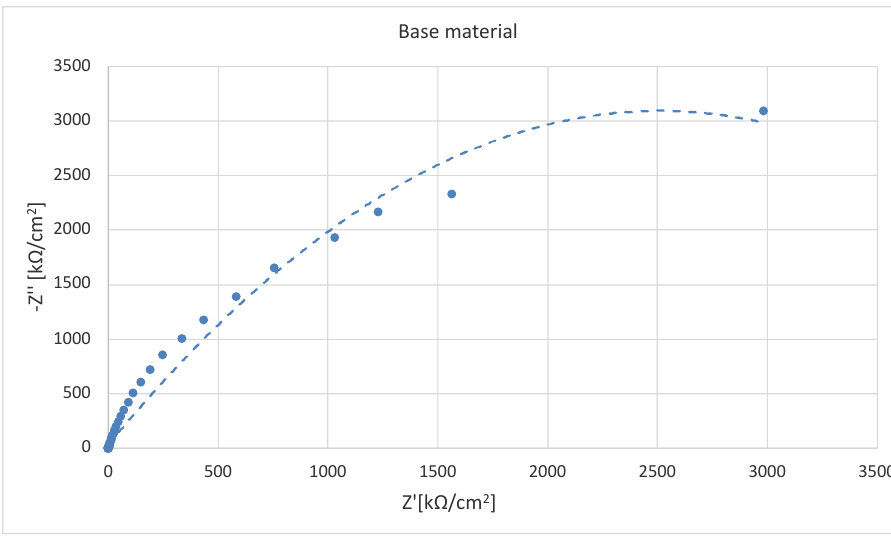
Figure 9. Nyquist plot for the sample in the initial state (supplied by the manufacturer).